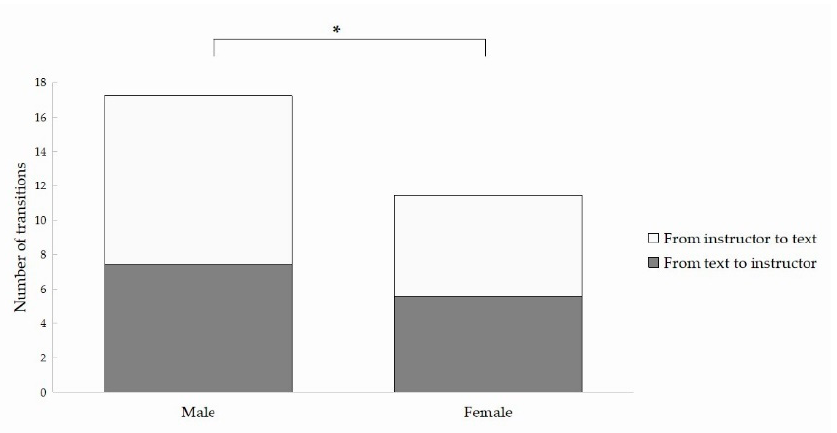
Figure 4. Number of transitions between the text and the instructor in the VV condition. * p < 0.05.